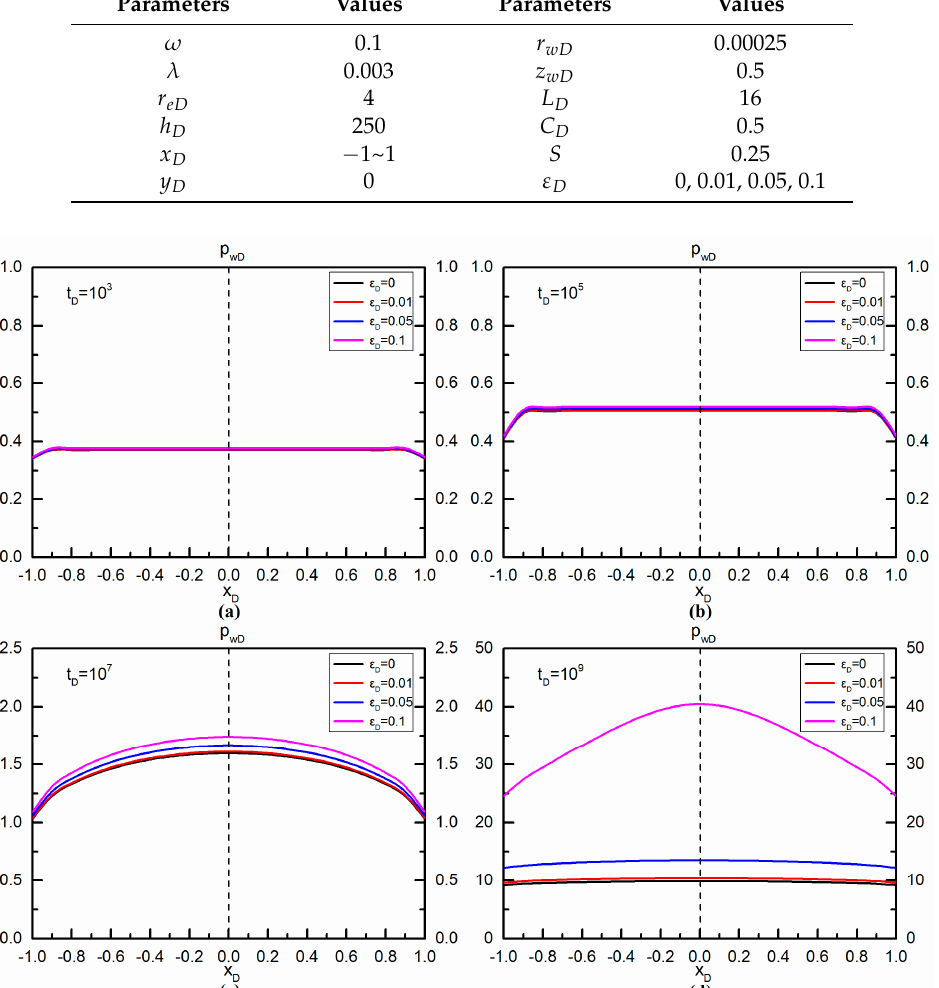
ε ) on horizontal wellbore pressure-drop